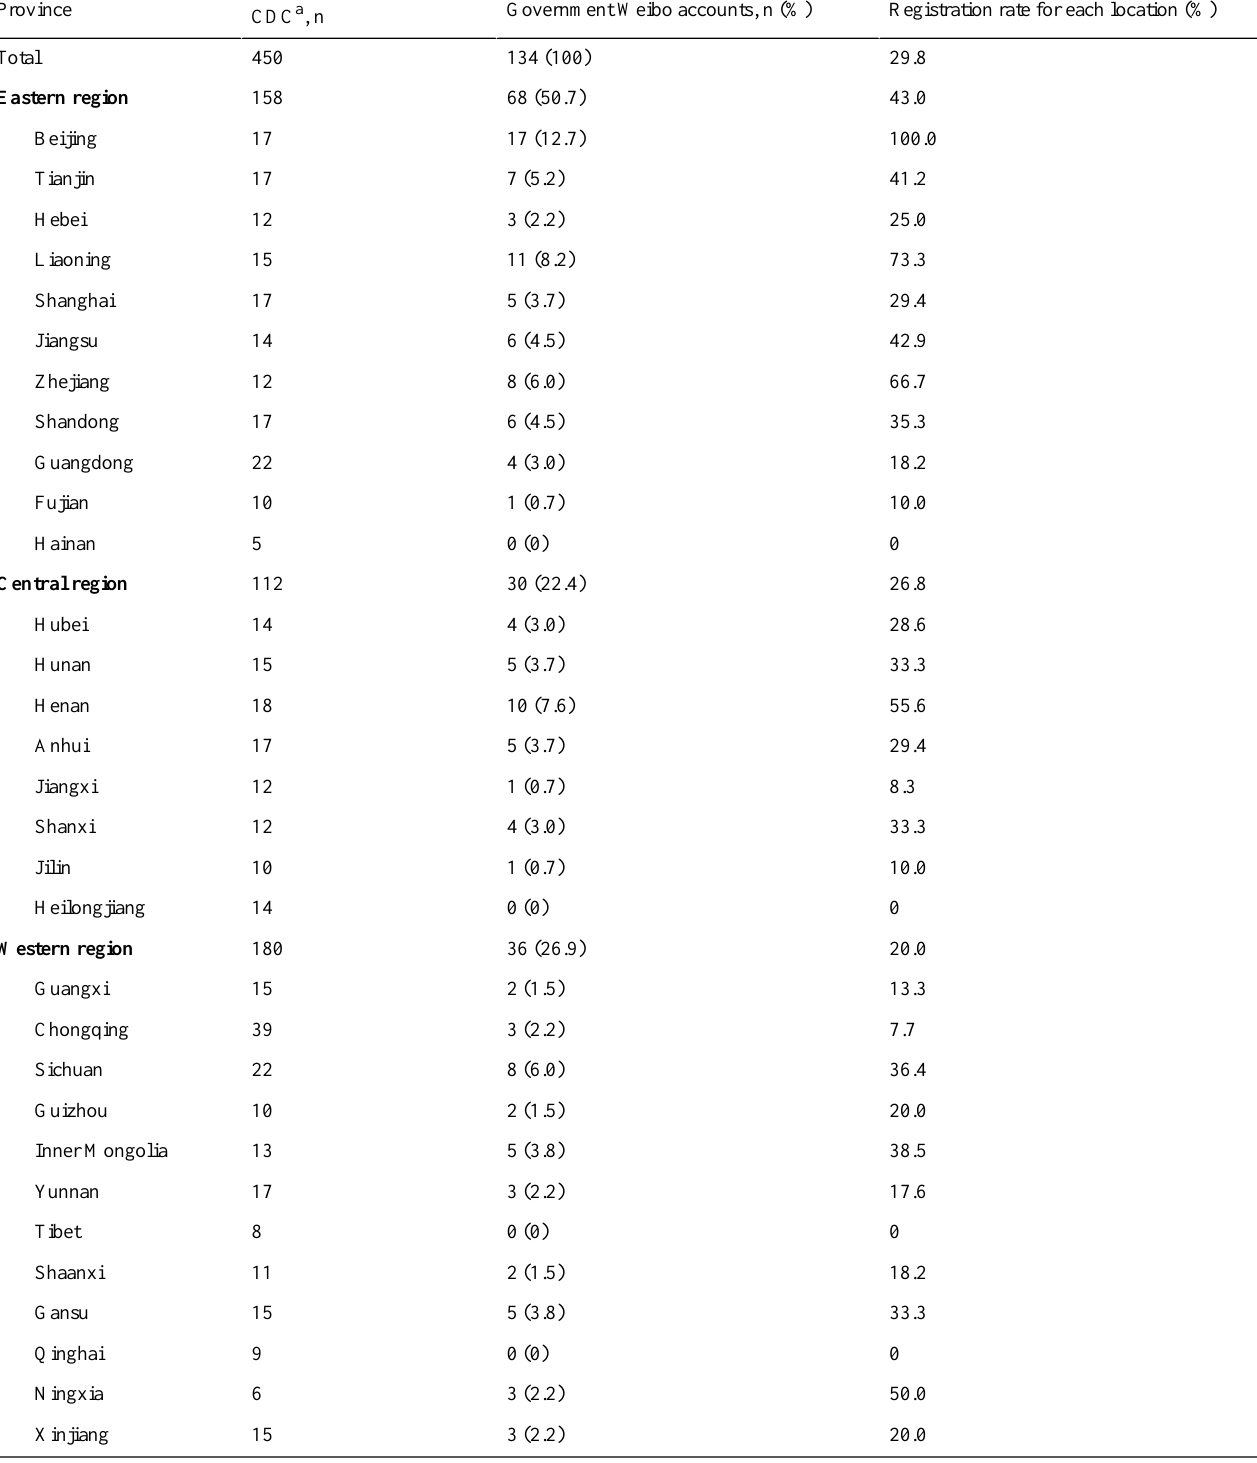
Table 1. Distribution of CDC facilities and the CDC’s government Weibo accounts in mainland